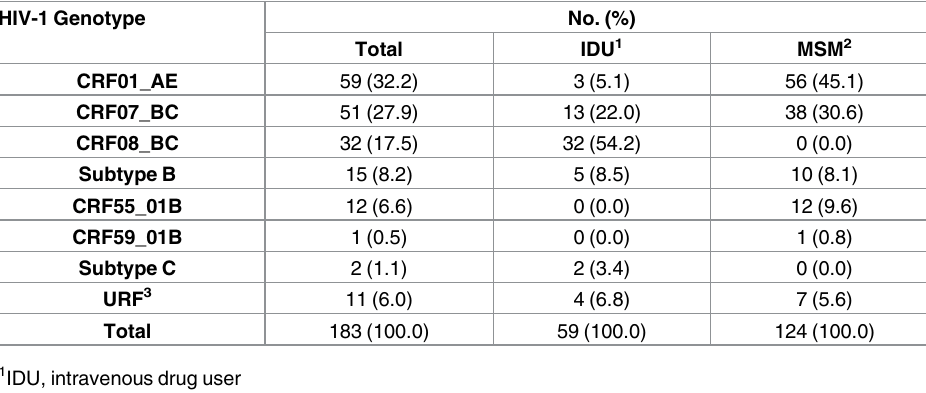
Table 1. HIV-1 Genotypes in IDU and MSM